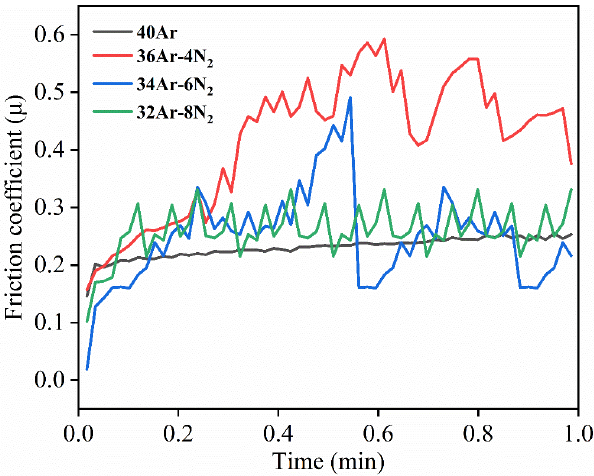
Figure 7. Friction coefficient of Ta 2 O 5 coatings prepared under different sputtering gas conditions.